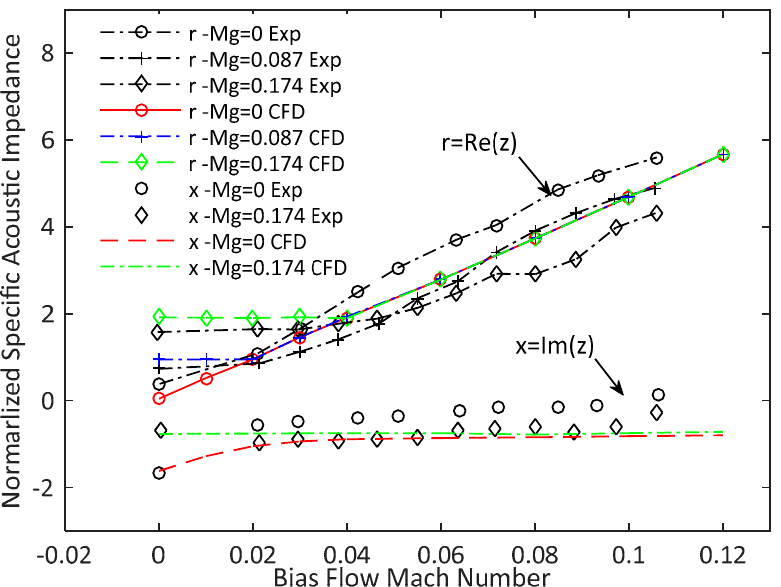
Figure 14. Numerical and experimental comparison of normalized specific acoustic impedance for liner JGB2 under various bias/grazing flow conditions [22].